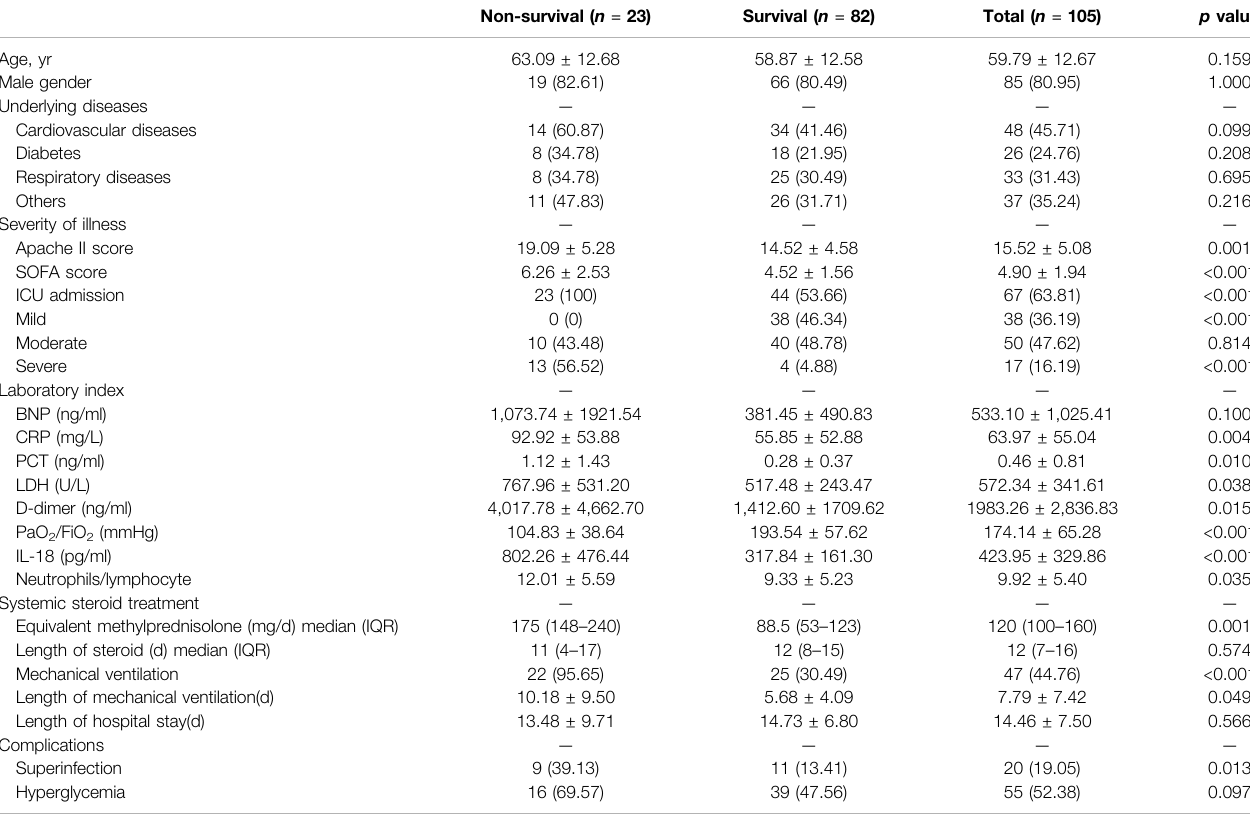
TABLE 1 | Baseline characteristics and outcomes after corticosteroid treatment for patients with acute respiratory distress